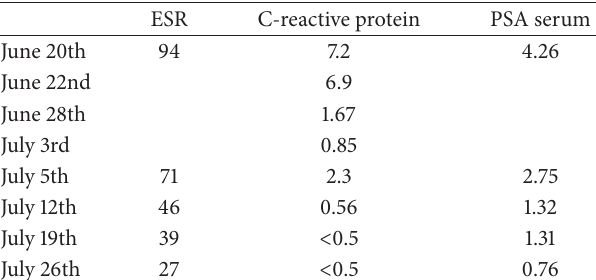
Figure 1: There is a multiloculated fluid collection centered in the prostate gland with multiple enhancing septations. Overall this lesion measures approximately 9 × 8 ×